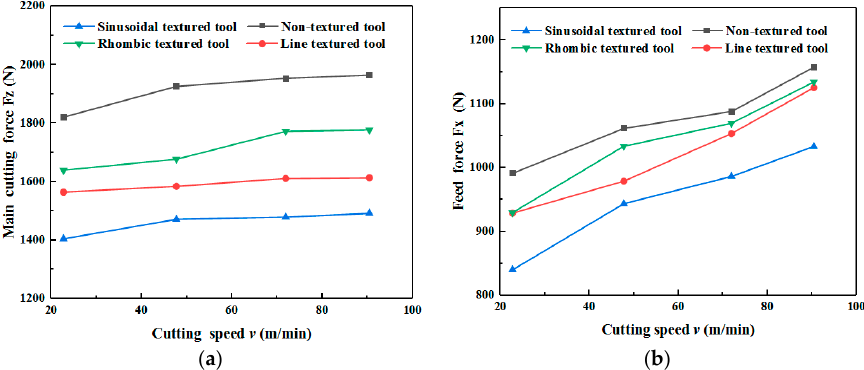
Figure 2. Main cutting force and feed force of tools at different cutting speeds ( a p = 0.3 mm). ( a ) Main cutting force; ( b ) Feed force.